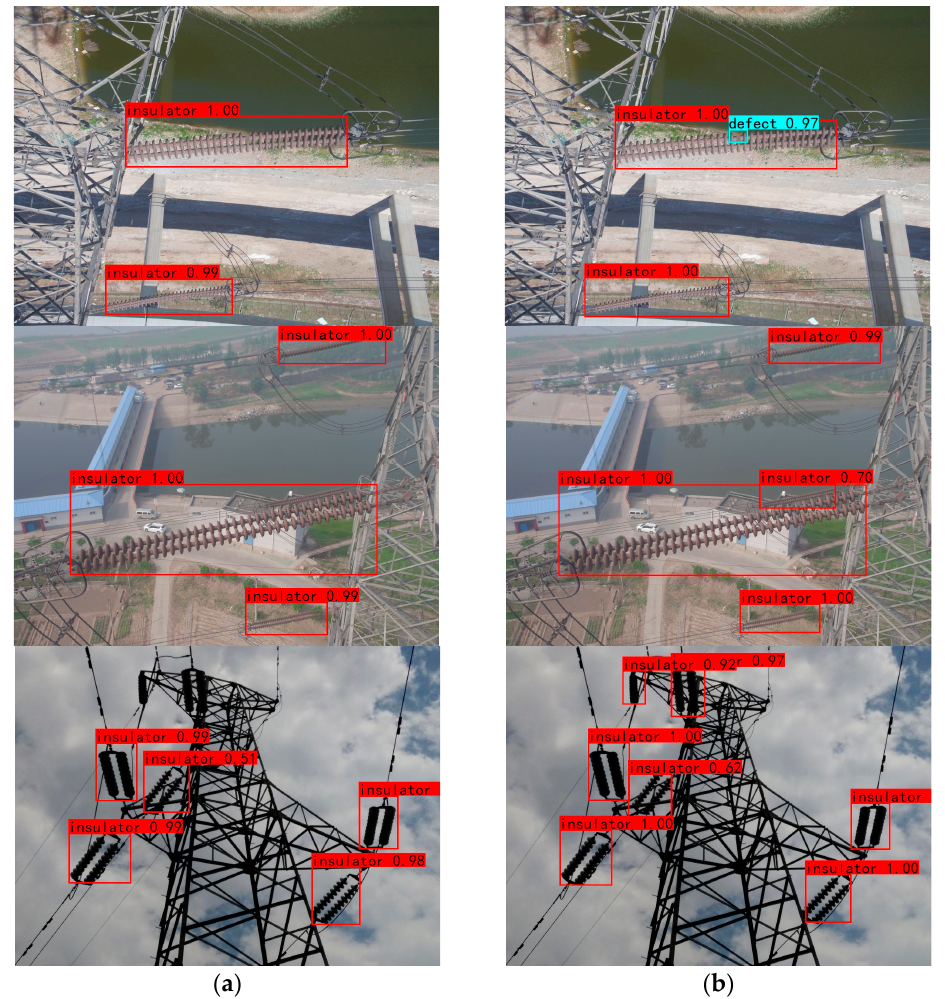
Figure 11. Comparison of the detection effects: ( a ) YOLOv4 algorithm; ( b ) YOLOv4–GhostNet–ECA algorithm.